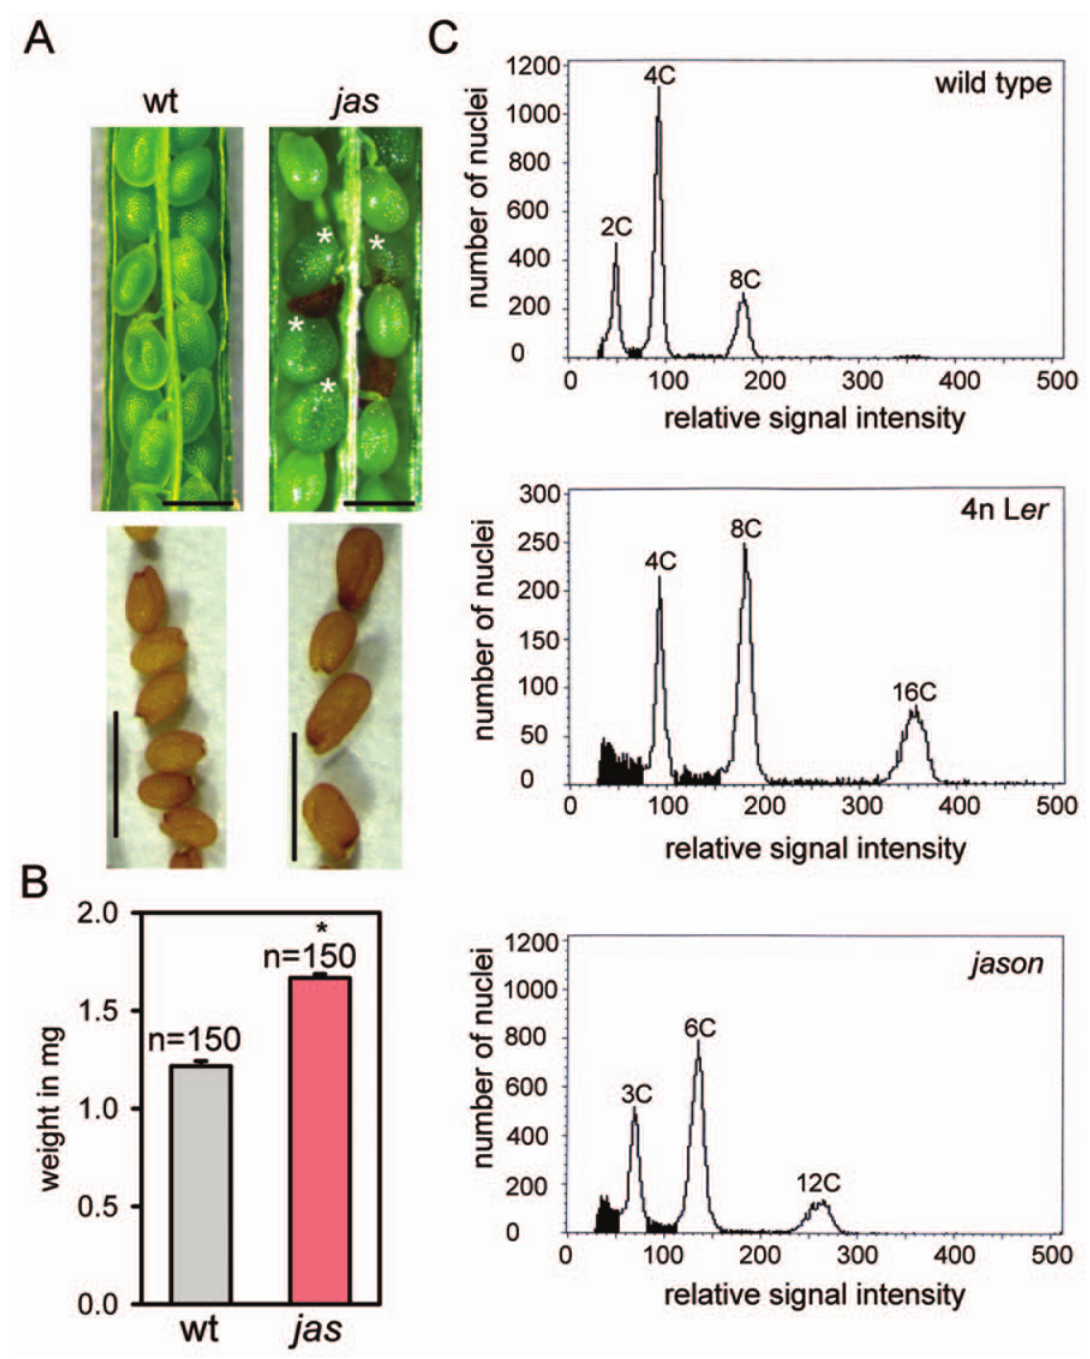
Figure 2. Homozygous jas plants produce significantly larger triploid seeds. (A) Silique from wild-type and jas plants after self-fertilization. Triploid jas seeds are enlarged (white asterisks) and sometimes abort (dark brown seeds). Lower panels show ripe seeds. Scale bars, 0.5 mm upper panels, 1 mm lower panels. (B) Seed weight of wild-type and jas plants. Average seed weight is given in mg per 50 seeds. Significance was determined by two-tailed Student’s t-test, * P , 0.01. Numbers above bars indicate numbers of scored seeds per genotype. Error bars, s.e.m. (C) Representative flow cytometry histogram plots of nuclei from wild-type, tetraploid (4n) and seedlings grown from enlarged jas seeds. doi:10.1371/journal.pgen.1000663.g002 To define the meiotic stage affected by the jas mutation, we and chiasmata as well as bivalents formed (Figure S2A, S2B, S2C, analyzed chromosome behavior during male meiosis in jas S2G, S2H, S2I). At metaphase II, however, we observed mutants. Chromosome spreads showed that meiosis in the jas differences to wild-type meiosis. Whereas wild-type chromosomes mutant progressed normally and was indistinguishable from wild- aligned into two well separated metaphase II plates (Figure S2D), jas chromosomes failed to align properly (Figure S2J), likely type meiosis until the end of telophase I. Synapsis was complete